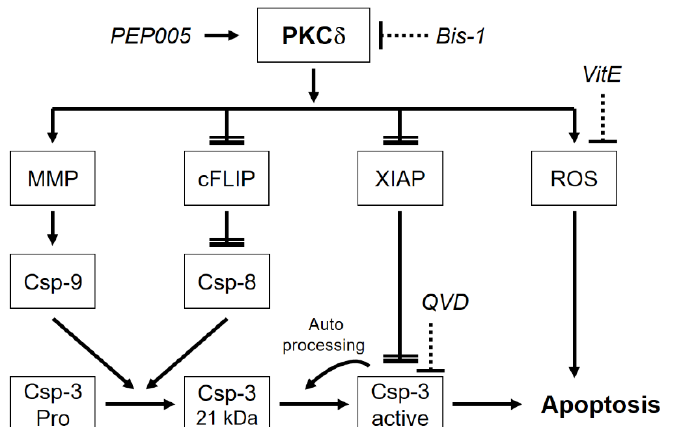
Figure 7. Molecular mechanisms of PKCδ-induced apoptosis in CTCL cells . In CTCL cells, PKCδ is induced by PEP005 and drives loss of mitochondrial membrane potential (MMP) related to caspase-9 activation, downregulation of c-FLIP related to caspase-8 activation, downregulation of XIAP related to caspase-3 activation as well as induction of reactive oxygen species (ROS) related to additional apoptosis promotion. The proform of caspase-3 (Pro) is cleaved by caspase-9 and caspase-8 to a 21 kDa intermediate product. Final processing to active caspase-3 is due to caspase-3 autocatalytic activity. For understanding the mechanisms, the PKC inhibitor bisindolylmaleimide I (Bis-1), the antioxidant vitamin E (VitE) and the pancaspase inhibitor QVD-Oph (QVD) were used. Further explanations are provided in the text.